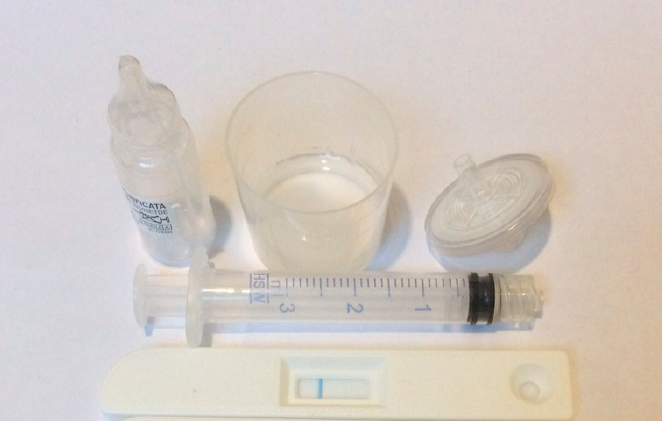
Figure 2. Salivary test kit used to detect the presence of aMMP-8 in periodontitis patients.